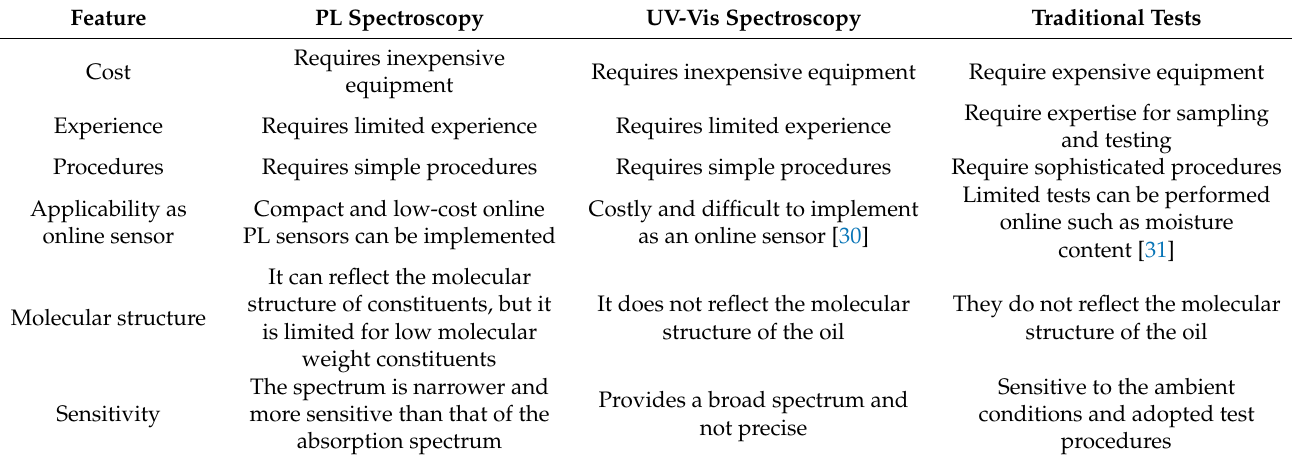
Table 1. Comparison between PL spectroscopy, UV-Vis spectroscopy, and traditional tests.